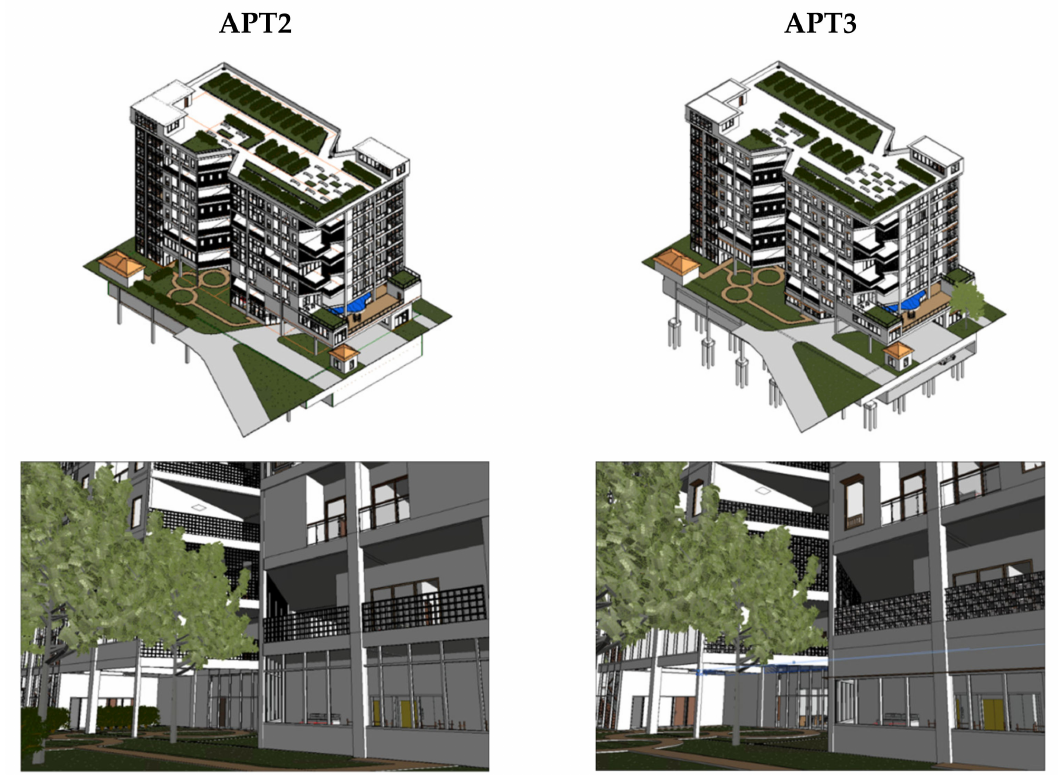
Figure 6. Design options of APT projects (APT2 and